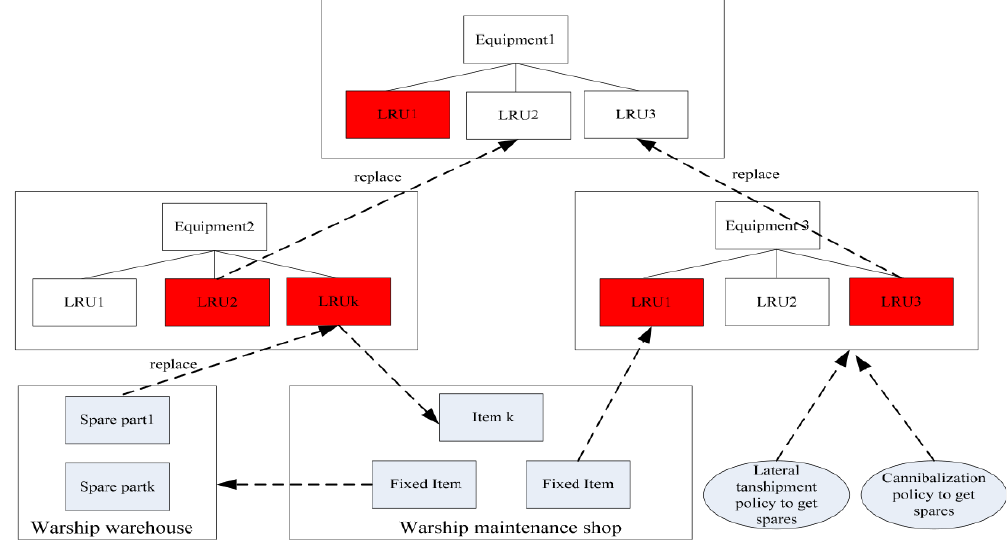
Figure 1. Maintenance process of failure item for warship spare parts support system